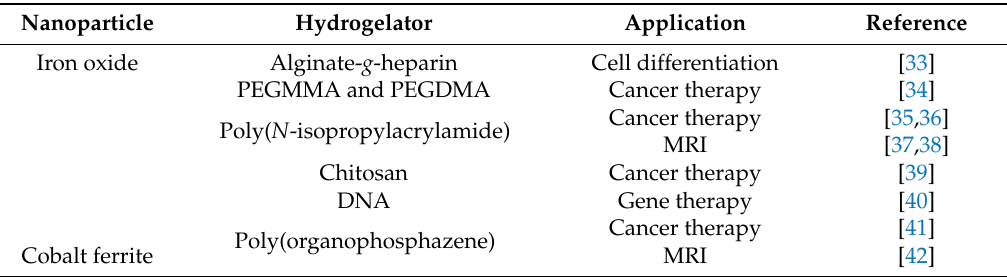
Table 1. Examples of biomedical applications of magnetogels according to the utilized nanoparticles and